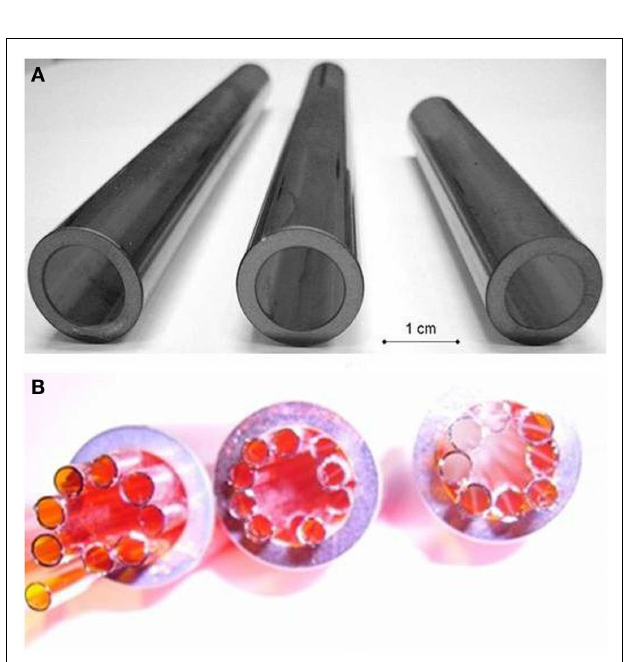
FIGURE 8 | Cross-sections of preforms (A) and microstructured fibers (B) (Shiryaev and Churbanov, 2013) .